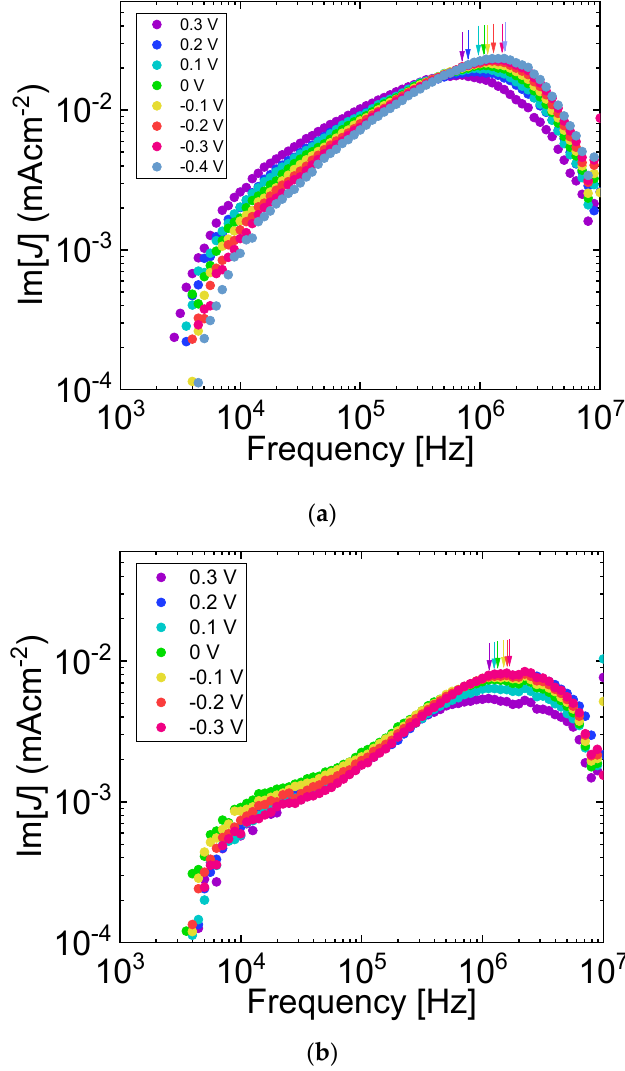
Figure 11. Imaginary part of MPC spectra of 40 wt% PTB7:PC 71 BM inverted OPV at different applied voltages ( a ) before and ( b ) after 5 h of photoinduced degradation. Arrows highlight frequencies from which charge carrier transit times were calculated.